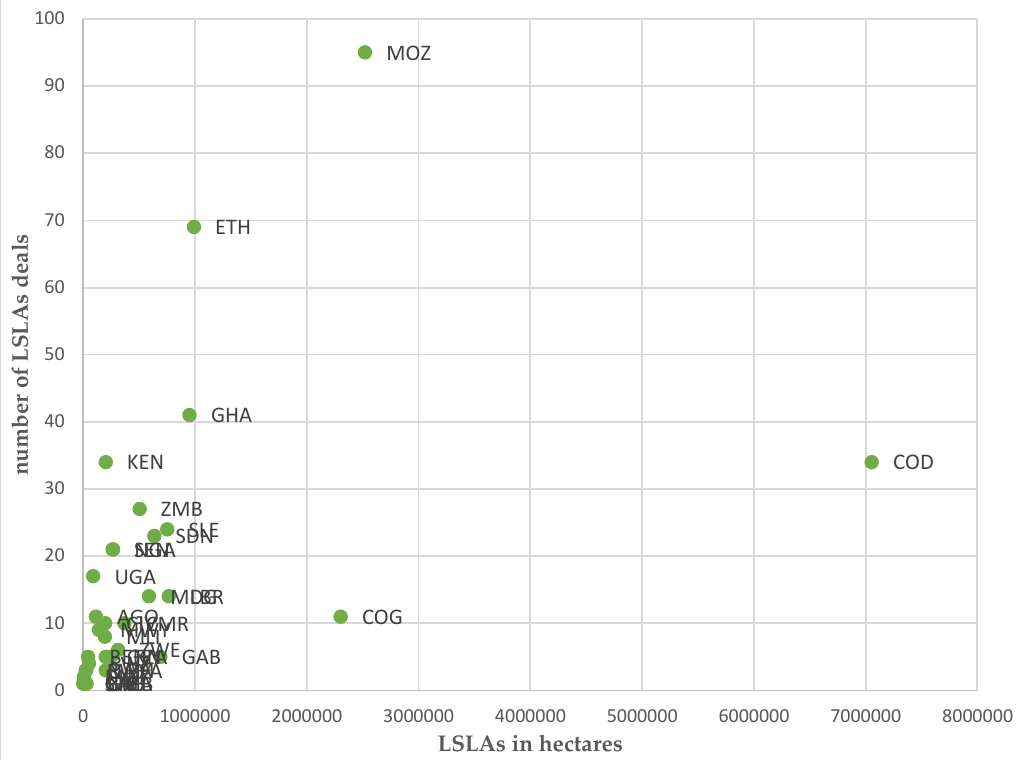
Figure 2. Scatter plot of LSLA surfaces (ha) and number of deals (number).